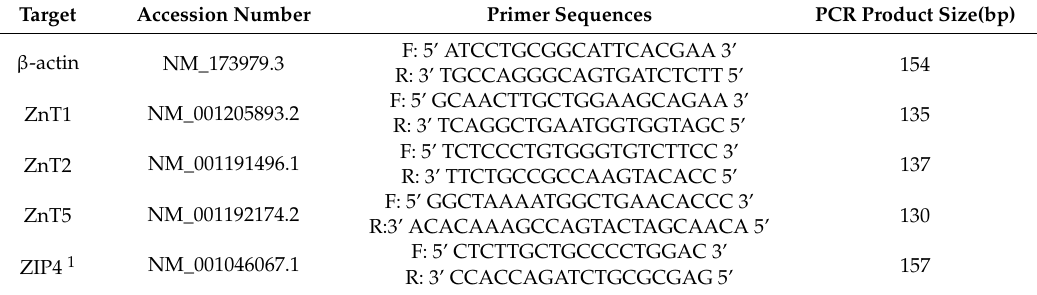
Table 2. Sequences of primers used to measure gene expression in the jejunal mucosa of calves by quantitative